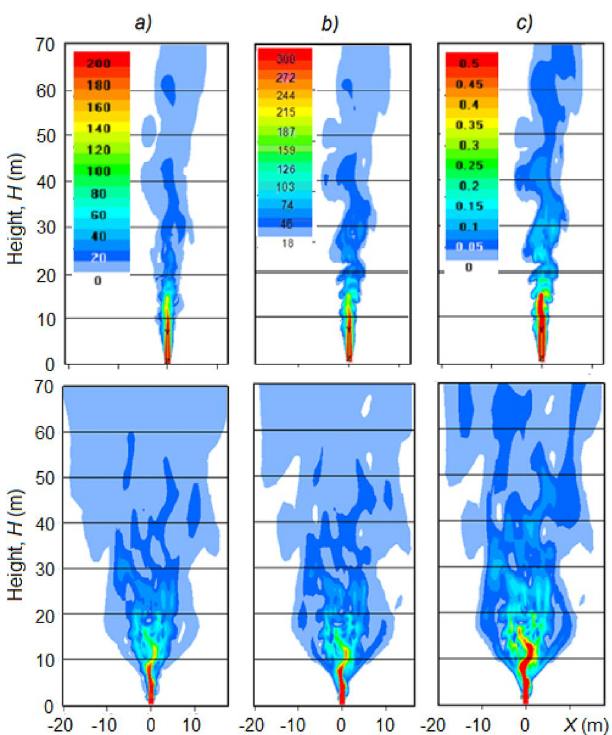
Figure 8. Vertical section of: ( a ) jet velocity W (m/s), ( b ) temperature T ( o C) ( b ), and ( c ) aerosol concentration C (g/m 3 ) in windless atmosphere ( U = 0 m/s) without inversion layers and γ = 6.5 °C/km, f = 45%. Top row without spraying of hygroscopic solutions, bottom row with spraying of